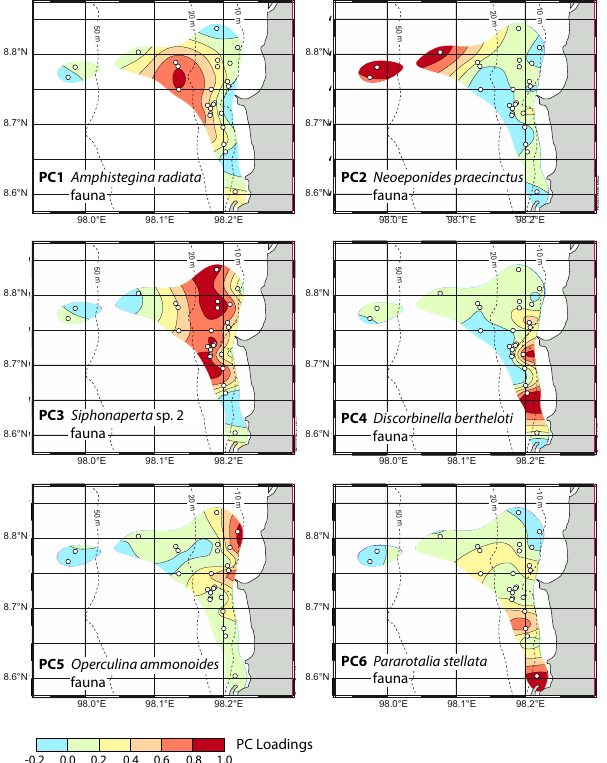
Fig. 4. Distribution of recent benthic foraminiferal assemblages ex- tracted with Q-mode principal component analysis. Shown are PC loadings. Loadings > 0.4 indicate statistically significant influence of the respective fauna (Malmgren and Haq, 1984). Ocean Data View (Schlitzer, 2012) was used for data interpolation. For scale bar see Fig. 1.